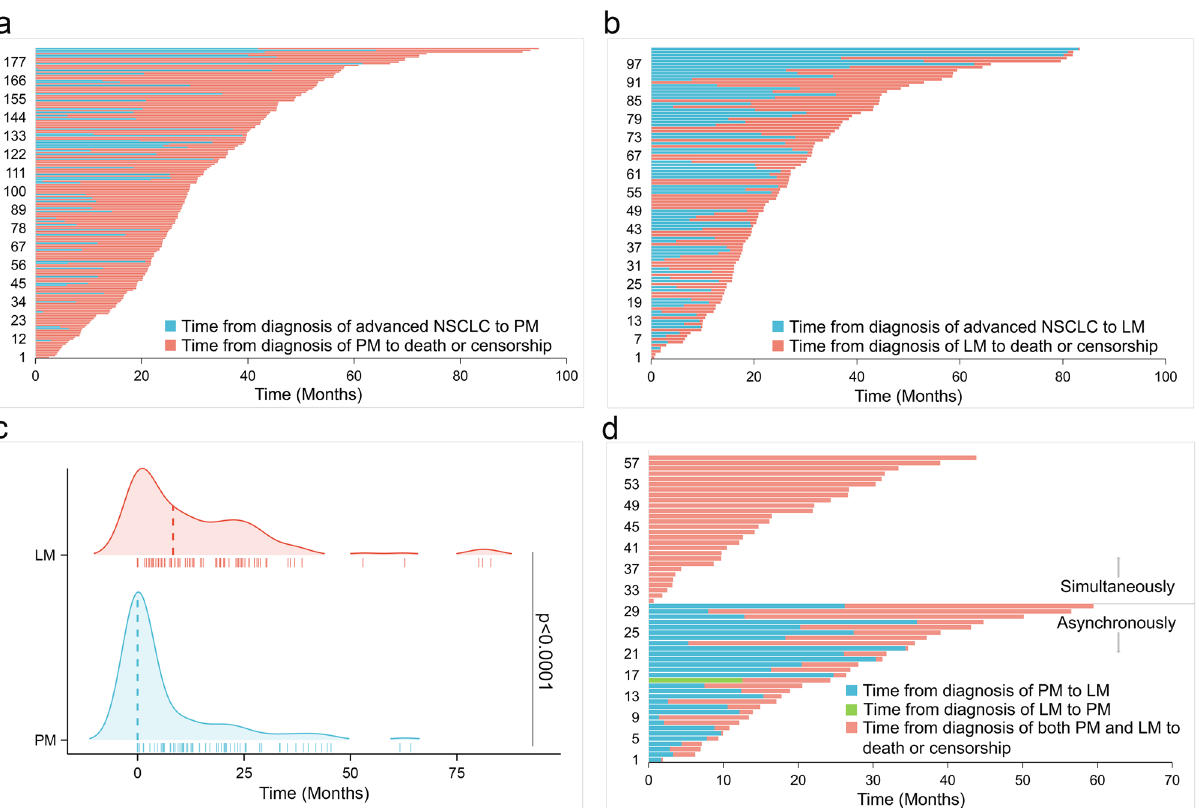
Figure 3. The time of PM and LM onset. The swimming plot from the diagnosis of advanced NSCLC to the onset of PM ( a ) or LM ( b ) and eventually to death or censorship. Summary of the onset of PM or LM during the clinical course of advanced NSCLC ( c ). The swimming plot of the patients with both LM and PM ( d